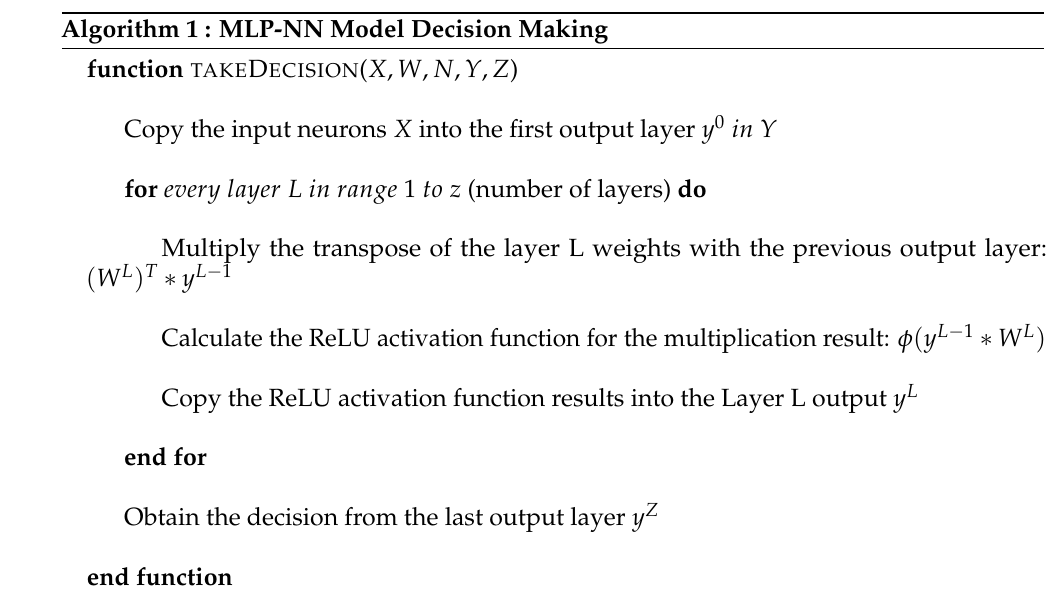
Algorithm 1 : MLP-NN Model Decision Making